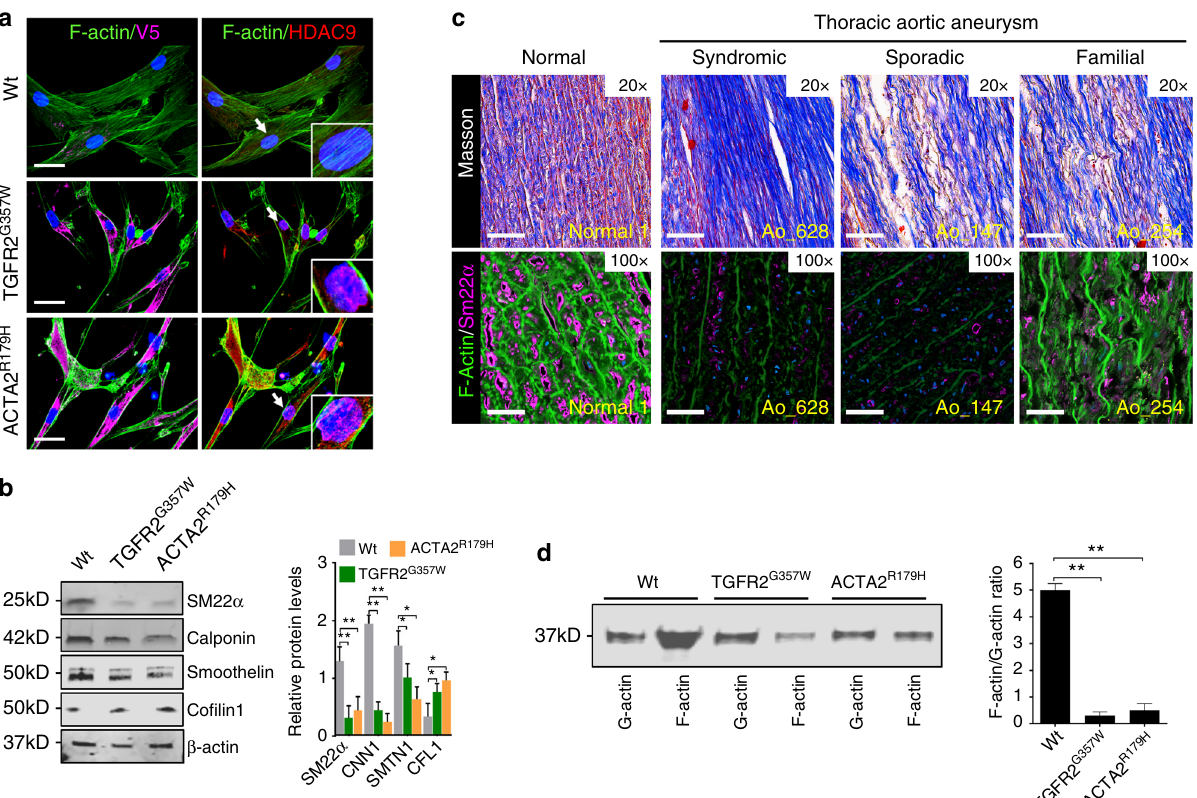
Fig. 2 TAA-related human genetic variation destabilizes the actin cytoskeleton. a Immuno fl uorescence of VSMCs transfected with TGFR2 G357W or ACTA2 R179H alleles (identi fi ed by anti-V5 staining, left column), and with anti-HDAC9 stain (red, right column), demonstrate loss of organized actin cytoskeleton structure with anti-F-actin staining, (green, both columns). Bar = 20 µ M, arrows indicate focus of 3× zoom inset panel. b Western blot demonstrates diminishment of alpha-smooth muscle actin ( α -SMA), calponin (CNN1), and smoothelin (SMTN1) expression in with TGFR2 G357W or ACTA2 R179H expressing cells. Three experimental replicates are quanti fi ed. c Masson Trichrome staining of human aortic samples (top row) blue color represents collagen deposition, and immuno fl uorescence of human TAA samples from diverse etiologies (bottom row) demonstrates decreased F-actin staining (green) staining with anti-SM22 α (magenta, all columns) when compared to control aortic tissue. Note, F-actin staining is noted between amorphous elastin fi ber auto fl uorescence. (20×, Bar = 50 µ M; 63×, Bar = 15 µ M). d Actin fractionation assay demonstrates decreased F-actin to G-actin ratio in with TGFR2 G357W or ACTA2 R179H expressing cells. Three experimental replicates are quanti fi ed. Bar graphs are presented as mean with error bars (±S.D.), Student ’ s T -test, * p < 0.05, ** p < 0.01 vs. WT. Full-length western blots presented in Supplementary Fig.